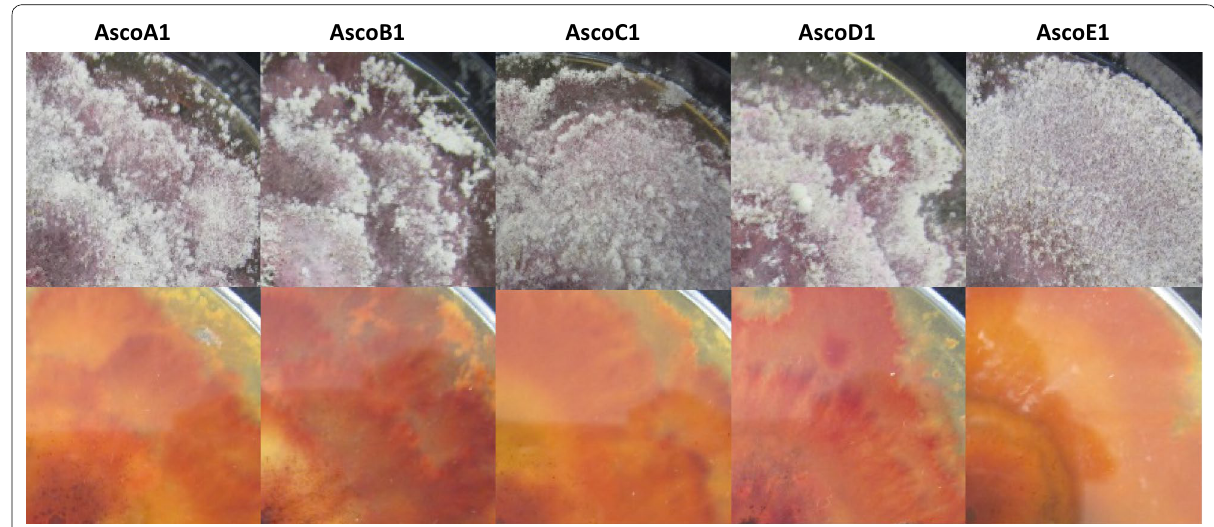
Fig. 5 Colony morphology of five isolated conidiogenous strains on YMG/T at RT after 25 days of incubation. Upper row: plates from top, lower row: